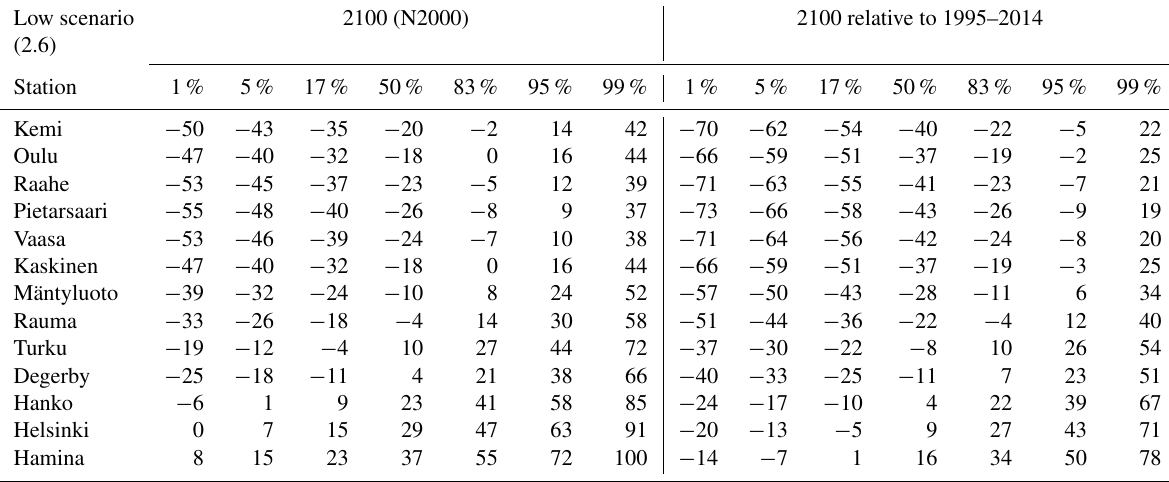
Table A2. Projected mean sea level (centimetres) at the Finnish tide gauges in 2100 under the low-emission scenario (RCP2.6/SSP1-2.6). Low scenario 2100 (N2000) 2100 relative to 1995–2014 (2.6) Station